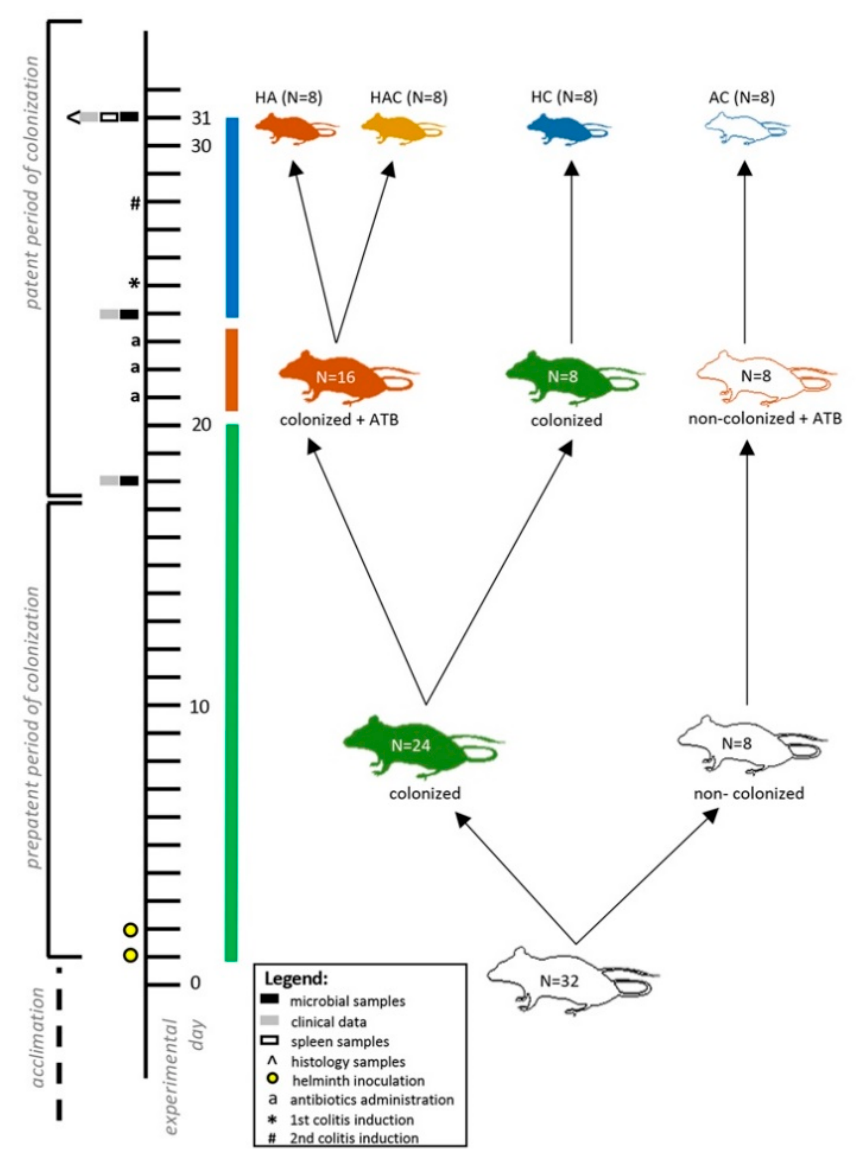
Figure 1. Graphic design of the experiment. The experiment involved three phases in which rats were affected by several factors: worm colonization (green bar; Days 1–20, but the H. diminuta colonization persisted throughout the experiment in the colonized rats), gut microbiota disruption (red bar; Days 21–24), and intestinal inflammation (blue bar; Days 25–31). The main monitoring and sample collection were performed on Day 31 (for more information see Material and Methods). There were four differently affected groups of rats: (i) treated with helminth and antibiotics (HA; red rat, N = 8); (ii) treated with helminth, antibiotics, and colitis (HAC; yellow rat, N = 8); (iii) treated with helminth and colitis (HC; blue rat, N = 8); (iv) treated with antibiotics and colitis (AC; white rat, N = 8). To evaluate the ongoing changes in the microbiota, fecal samples were collected throughout the experiment—on Days 0, 18, 25, and 31 (i.e., after colonization, after antibiotics administration, and after colitis induction). ATB—antibiotics.